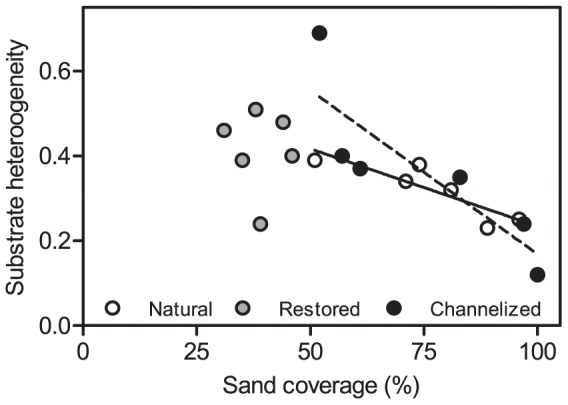
Relationship between stream bed sand coverage and substrate heterogeneity in the 3 stream types.The solid regression line describes the relationship in natural streams and the dotted line is the fitted line for channelized streams.